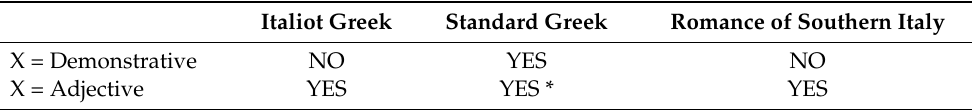
Tables 1–3 sum up and compare the patterns of linearization of adjectives and demon- stratives in Italiot Greek, standard Greek and Romance of Southern Italy. 32 Table 1. Num N X .